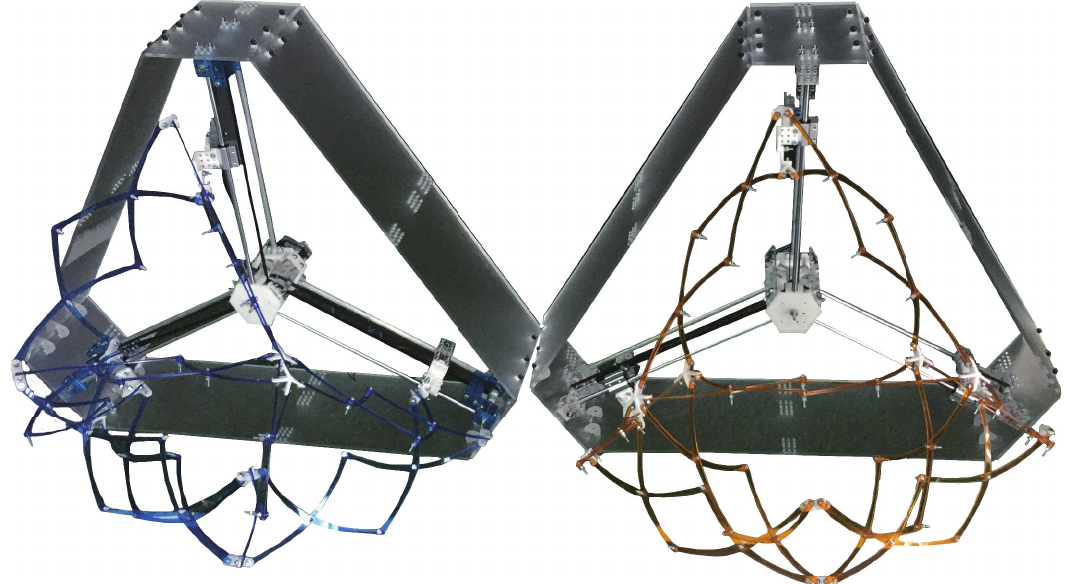
Figure 7. Early component configuration prototype models for kinetic components based on the scissor